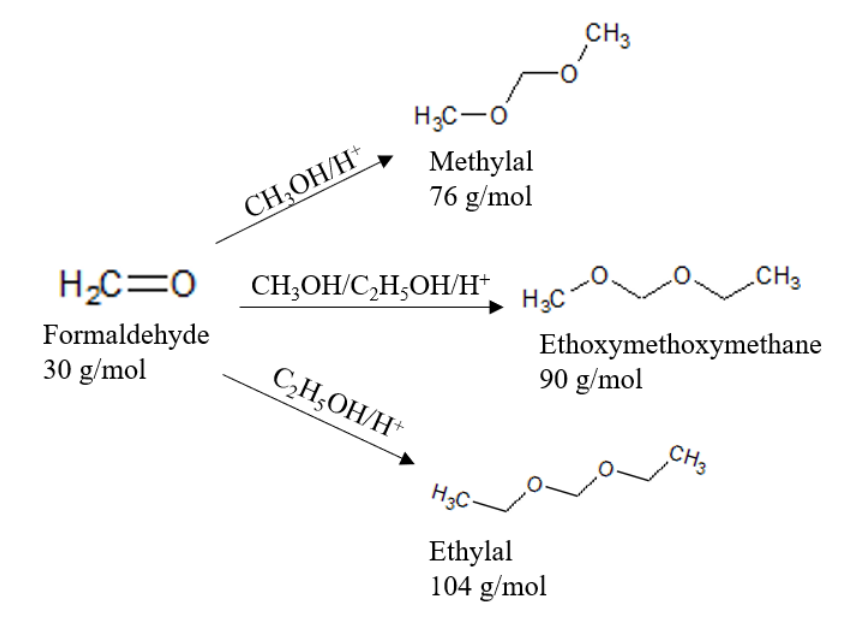
FIGURE 1 - Derivatization of formaldehyde by acid catalytic reaction using methanol, ethanol and methanol/ethanol, showing the formation of the acetals methylal, ethoxymethoxymethane and